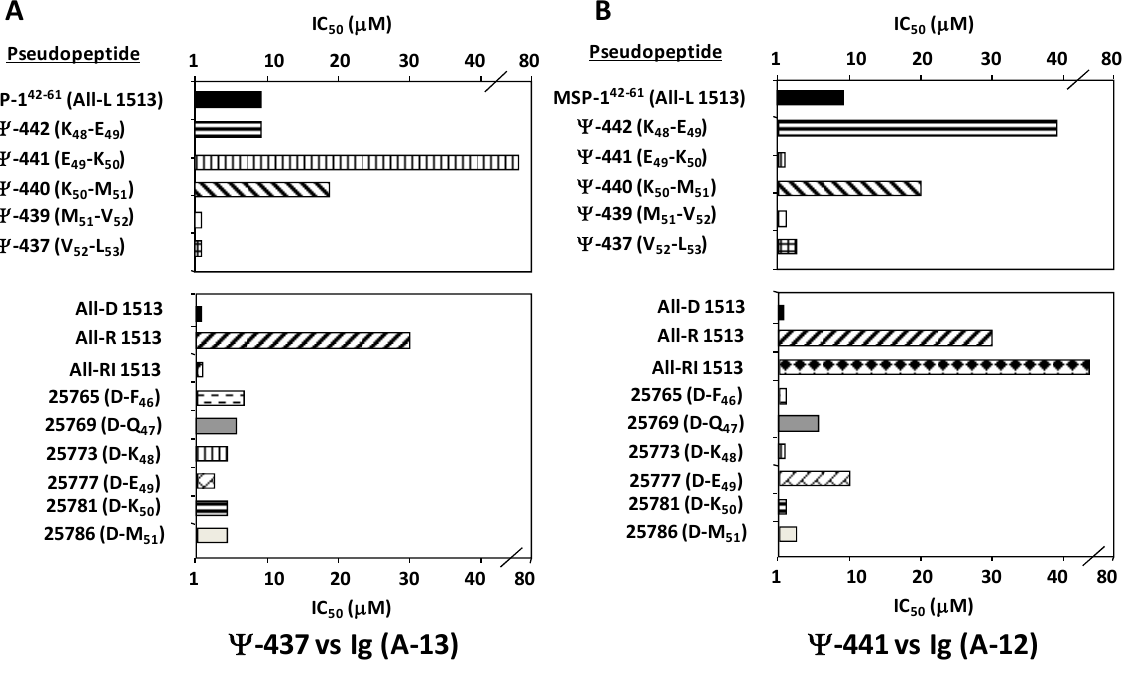
Figure 5. Effects of introducing reduced peptide bonds into MSP-1 42–61 -derived peptides on purified A-13 and A-12 mAbs molecule binding. Serial dilutions (1-100 nM) of unmodified parent peptide and its pseudopeptide derivatives were incubated with either A- 13 in ( A ) or A-12 in ( B ) mAbs in the presence of 4.66 nM  -437 and  -441 reporter pseudopeptide, respectively. IC values are given as the average of triplicates from one 50 representative